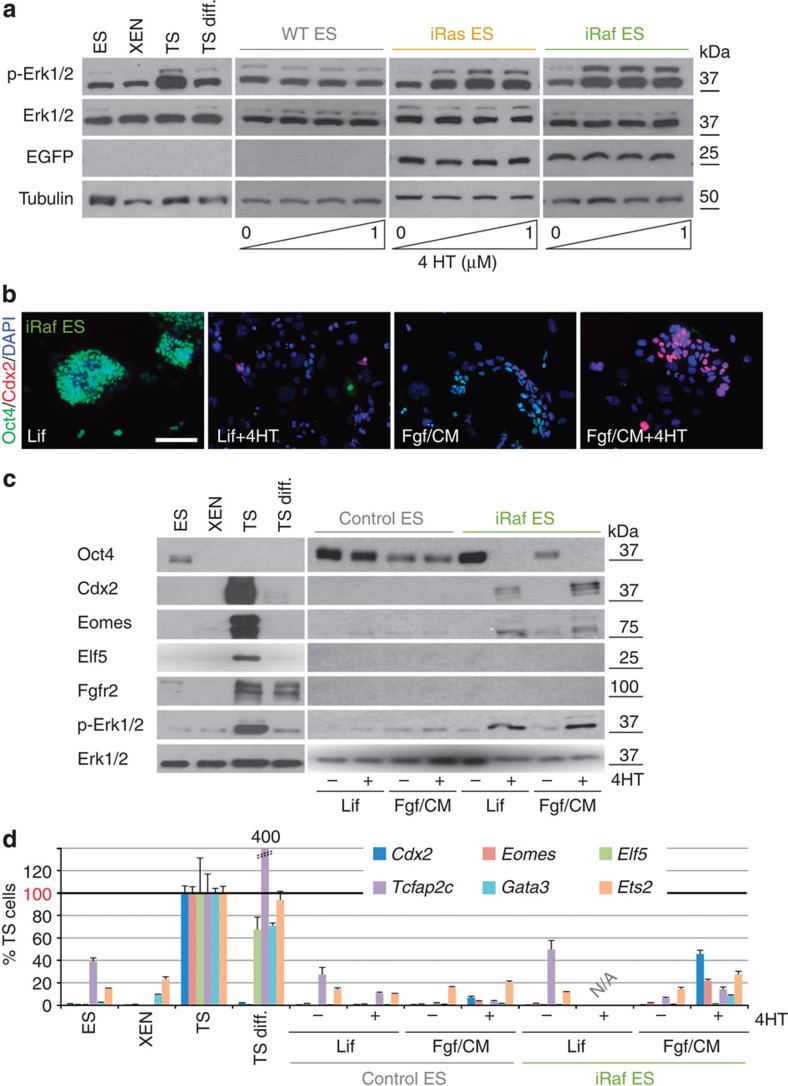
Constitutive Ras and Raf activation in ES cells leads to Cdx2 upregulation but is insufficient to induce trophoblast differentiation.(a) Established iRas and iRaf ES cells, as well as wild-type (WT) control ES cells, were cultured in TS cell conditions for 24 h in the presence of increasing concentrations of 4HT. Erk1/2 phosphorylation at levels similar to those in TS cells was achieved in the chosen ES cell clones. (b) Immunofluorescence staining for Oct4 and Cdx2 of iRaf ES cells after 7 days of culture in ES cell conditions (‘Lif’) or in TS cell conditions (‘Fgf/CM’) in the presence or absence of 4HT. Raf kinase activation in TS cell conditions induced high levels of Cdx2 but these cells did not necessarily acquire trophoblast morphology. Scale bar: 100 μm. (c) Western blot of iRaf and control ES cells (stably transfected with an empty EGFP expression construct) after 6 days of culture in the indicated conditions. TS cell conditions in the presence of 4HT induced Cdx2 and Eomes, albeit not to TS cell levels. Elf5 and Fgfr2 were not induced, even upon long exposure (Supplementary Fig. 8b). (d) RT–qPCR analysis of control and iRaf ES cells after 7 days of culture in the indicated conditions, normalized to TS cell values and displayed as mean±s.e.m. of three biological replicates. Cdx2 was activated by Raf induction in TS cell conditions to ~50% TS cell levels; other TS cell-characteristic transcription factors were expressed at levels far lower than those in TS cells.